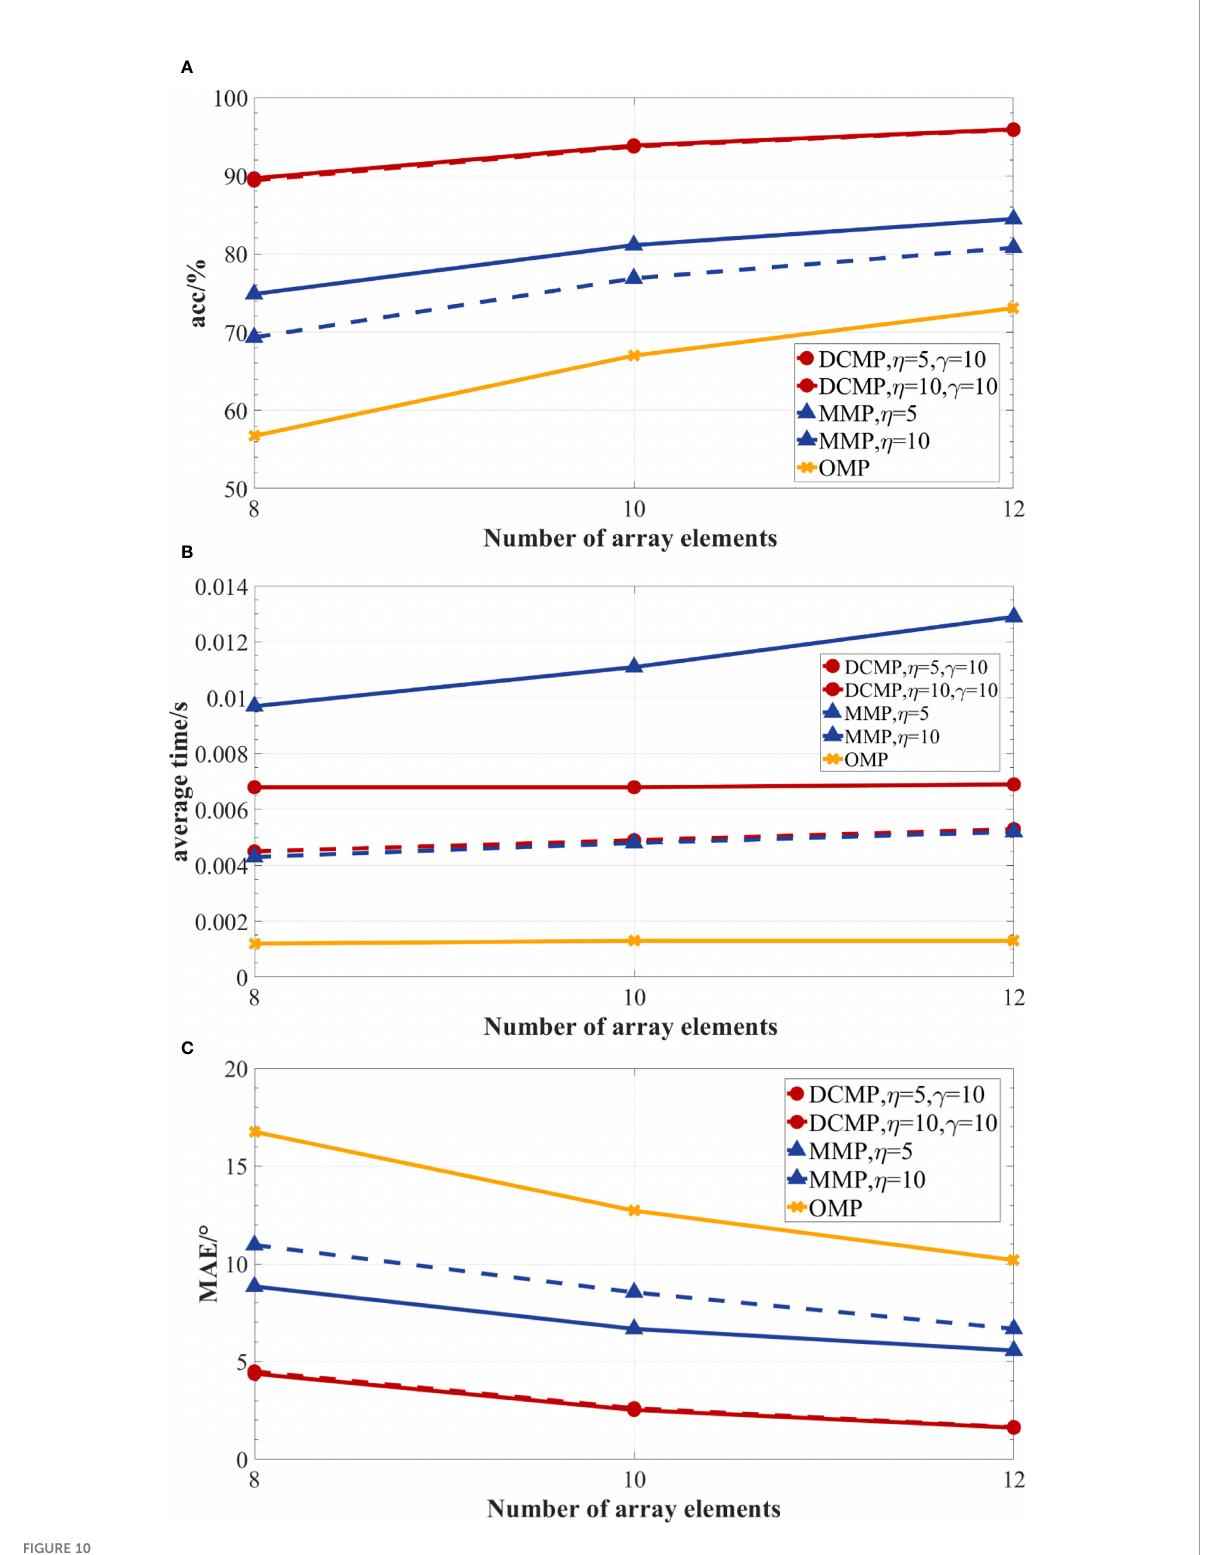
FIGURE 10 The performances of the DCMP, MMP, and OMP algorithms for different array types under the SNR of 20 dB, two sources, and 96 snapshots. (A) DOA prediction accuracy; (B) average estimation time; (C)